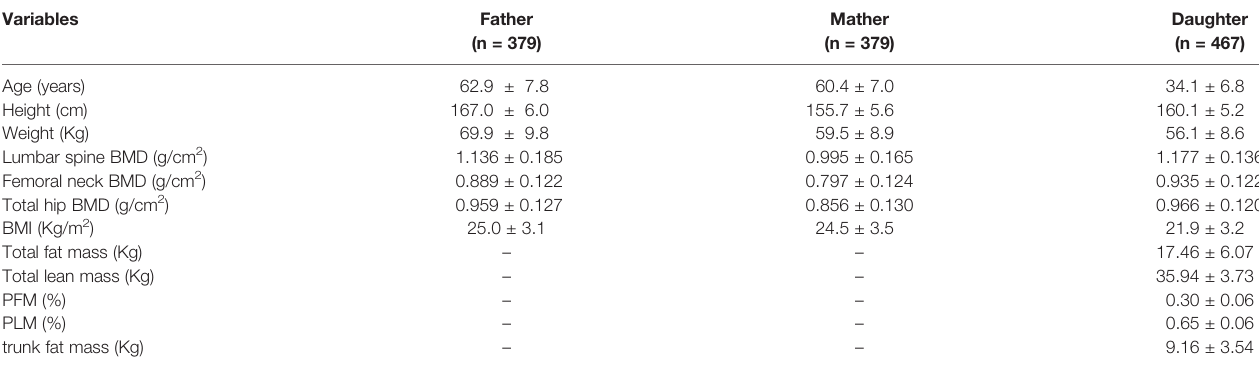
TABLE 1 | The basic characteristics of the female-offspring nuclear families (mean ±